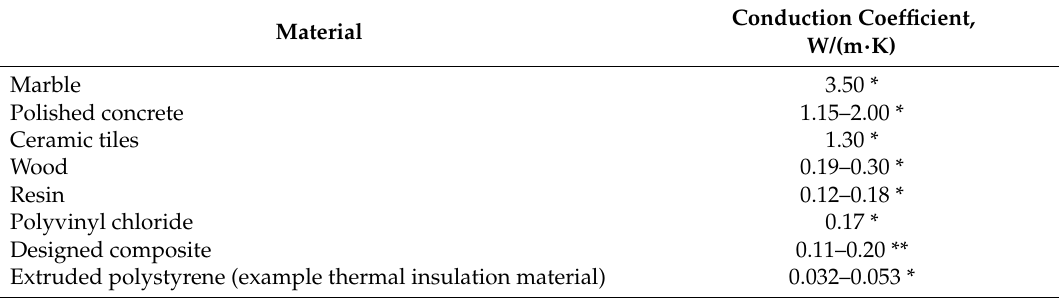
Table 5. Values of coefficients λ for selected finishing materials.